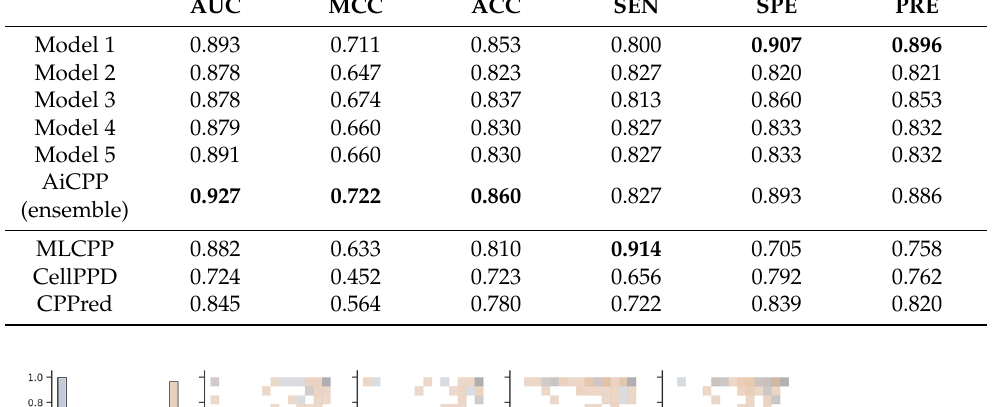
Table 3. Performance evaluation of the CPP predictors. The best performance metrics are in bold.